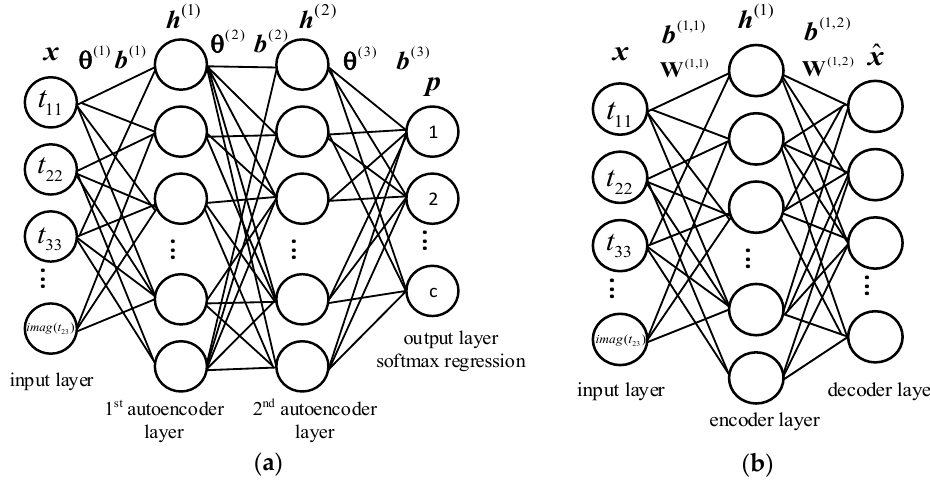
Figure 1. ( a ) Two-layer autoencoder with softmax regression neural network; ( b ) 1st autoencoder network.